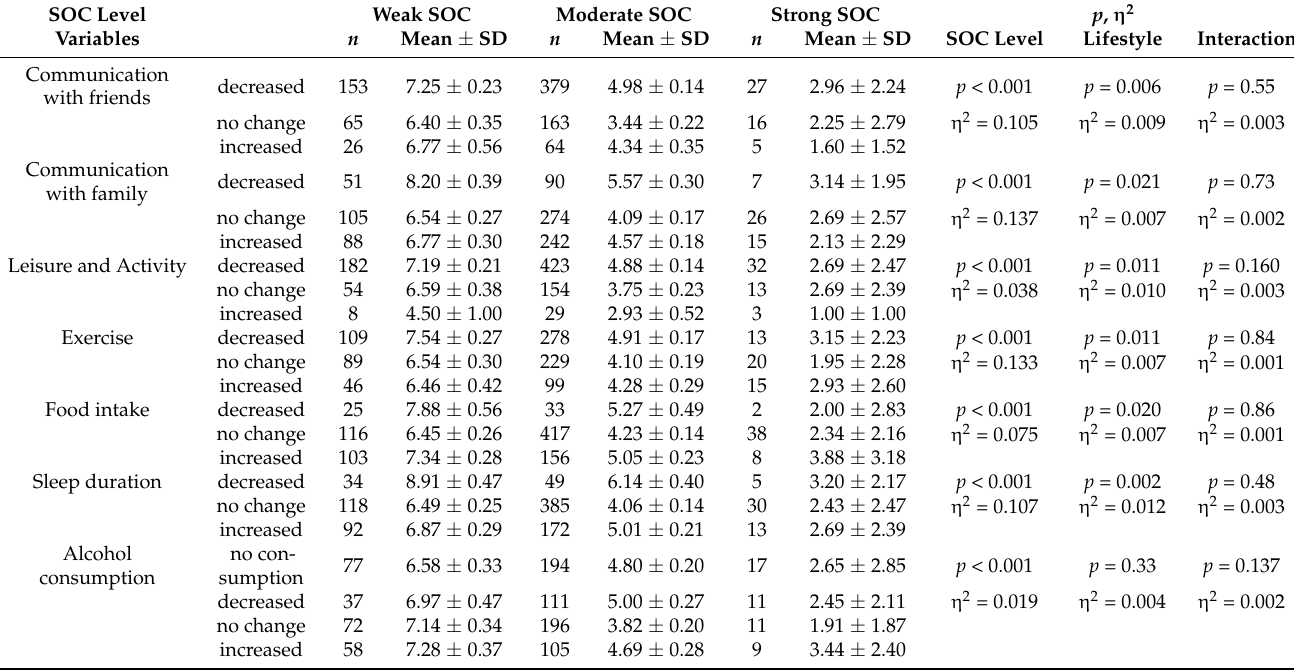
Table 3. Mean GQH-12 scores according to SOC level and p -values of main and interaction effects. SOC